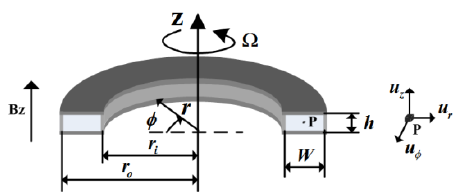
Figure 2. The parameter and coordinates addressed in the section of the annual channel in MHD ARS.